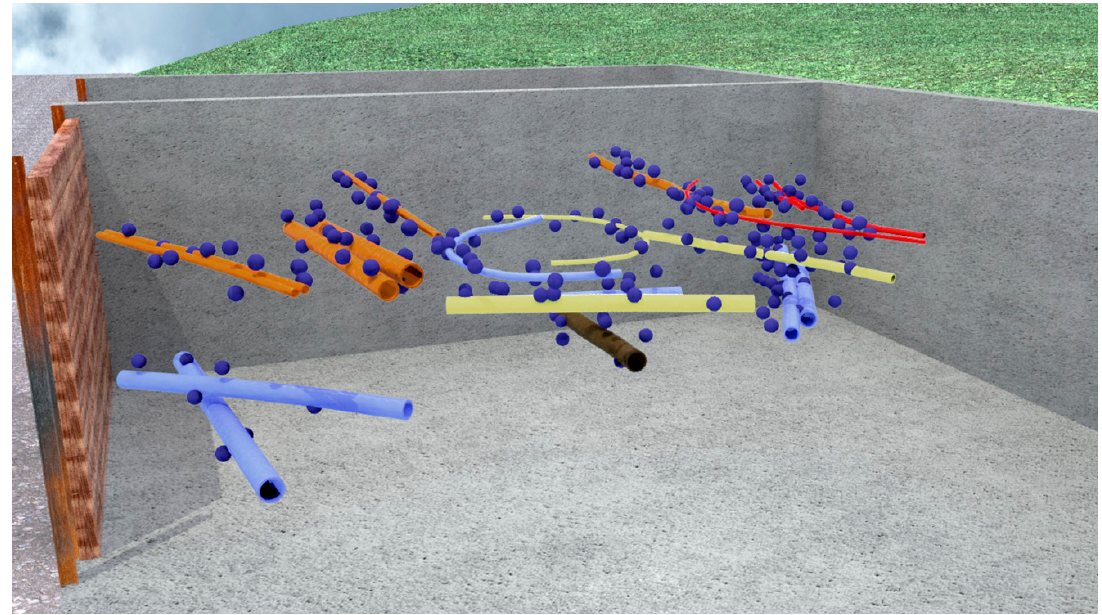
Figure 20. Cables, cable ducts and pipes visualised with the regression analysis from the dependent GPR measured apex points (blue points), determined with the proposed kinematic GPR-TPS model in the 3D space.